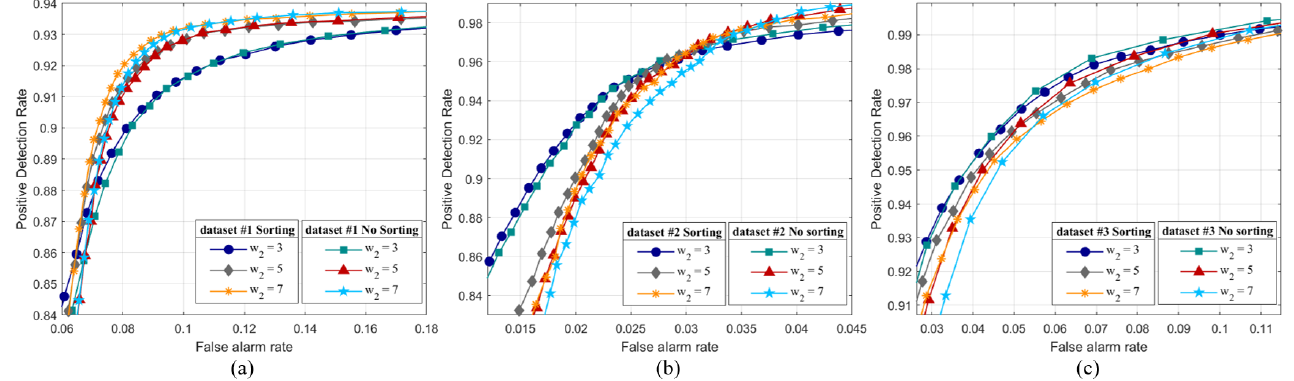
Figure 10. The ROC curves of the NLSW and SNLSW detectors on Datasets #1/2/3. ( a ) ROC curves on Dataset #1. ( b ) ROC curves on Dataset #2. ( c ) ROC curves on Dataset #3. Table 5. Quantitative analysis of the SNLSW and NLSW on Datasets #1/2/3 with w 1 = 2, w 2 = 3. Metric